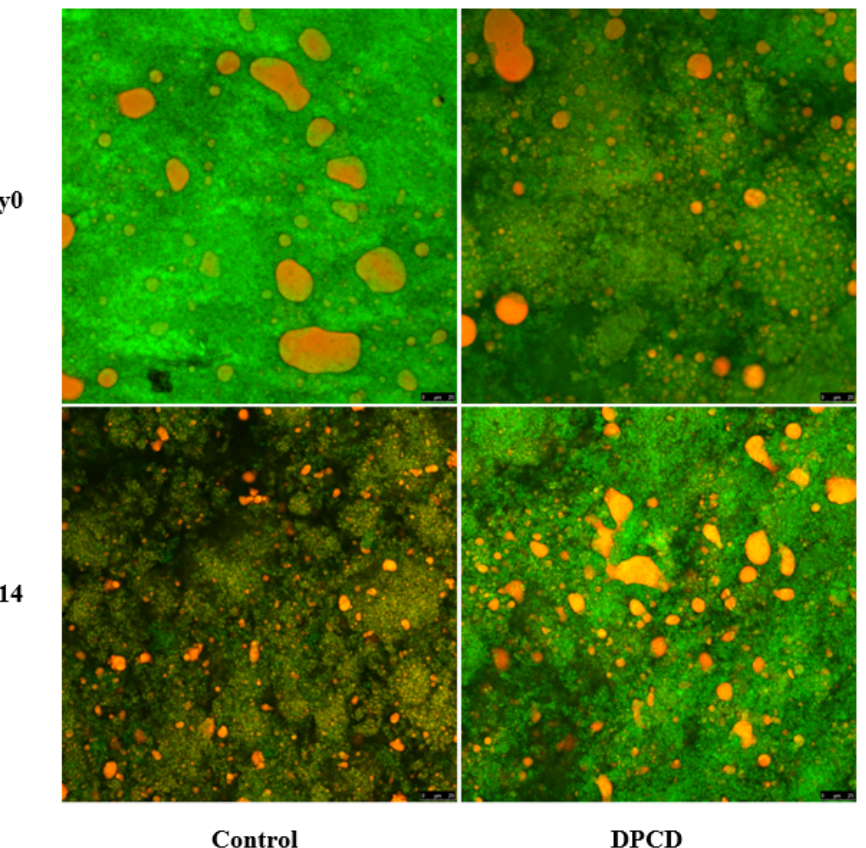
Figure 1. Microstructure of control and dense-phase carbon dioxide (DPCD)-processed quark cheese stored at 4 °C.